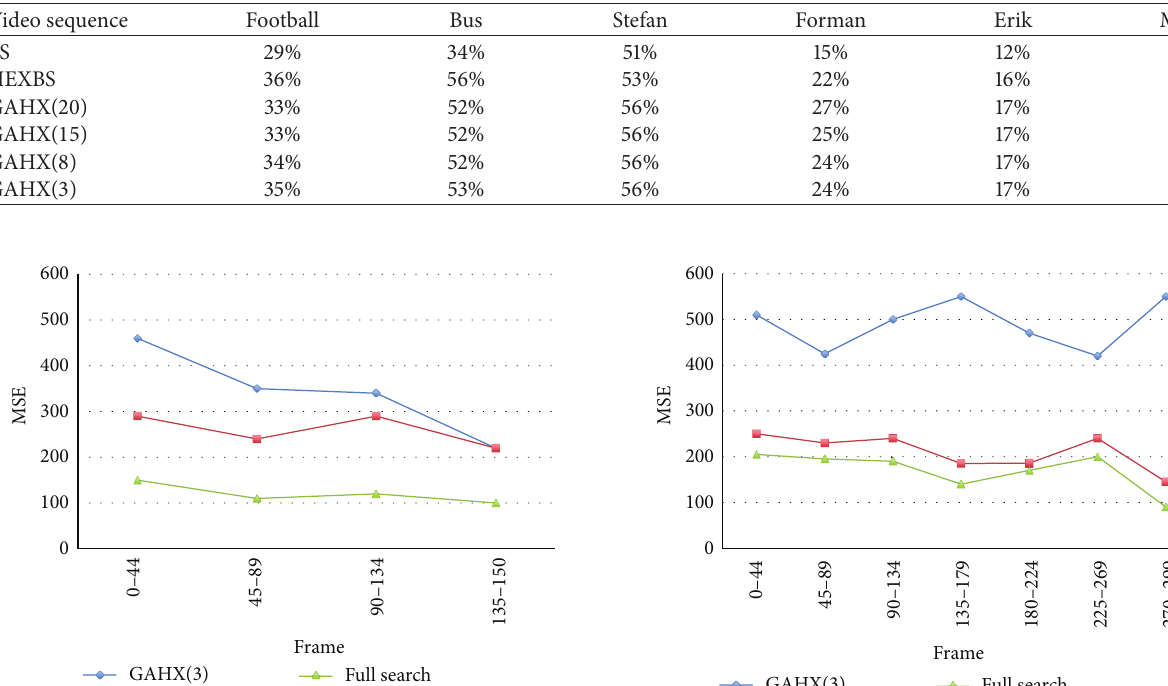
Table 2: Average percent rate of PSNR worse than 30 dB per frame for various video sequences compared with various schemes.